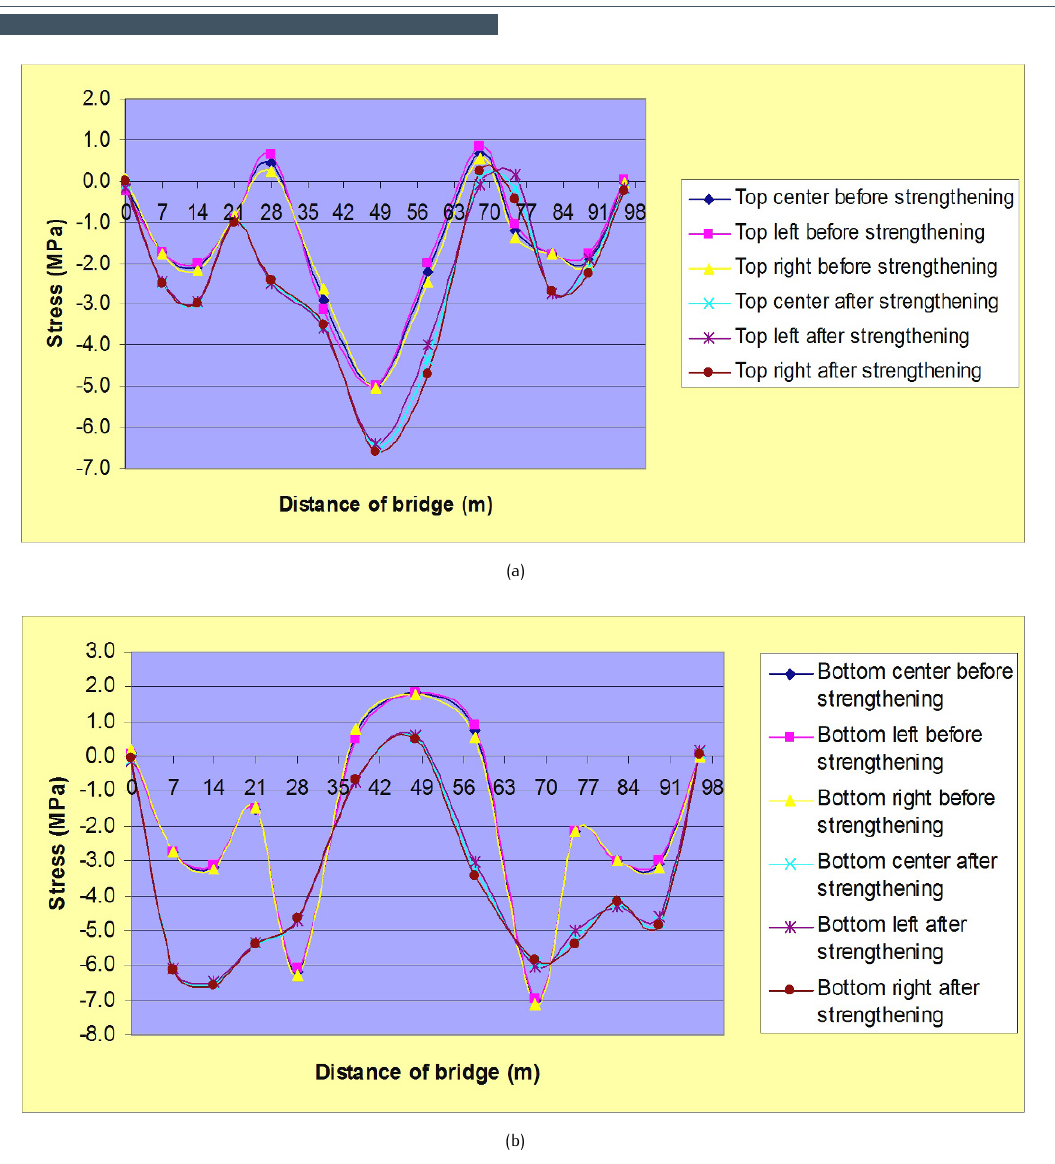
Figure 11. The values of stresses before and after strengthening due to load combination I for object No.2, (a) top of box girder, (b) bottom of box girder